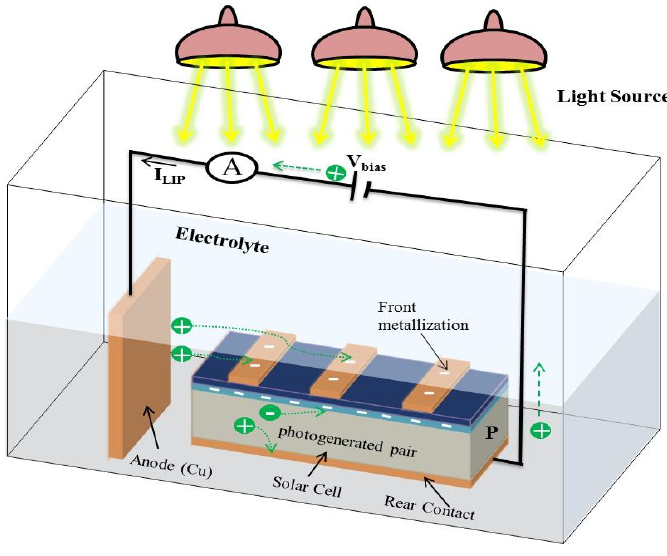
Figure 1. Schematic diagram of the light induced plating (LIP) based Cu electroplating process